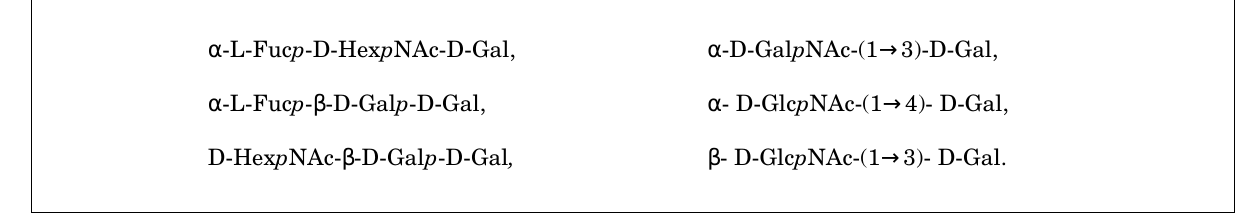
Fig. 4. Oligosaccharide structures.